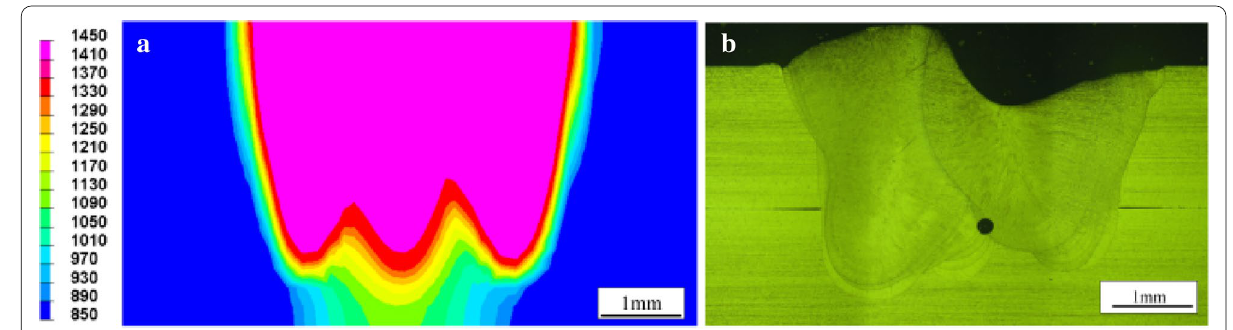
Figure 20 Weld joint morphology of new 6-sections: a Numerical simulation of molten pool morphology; b Actual welded joint morphology